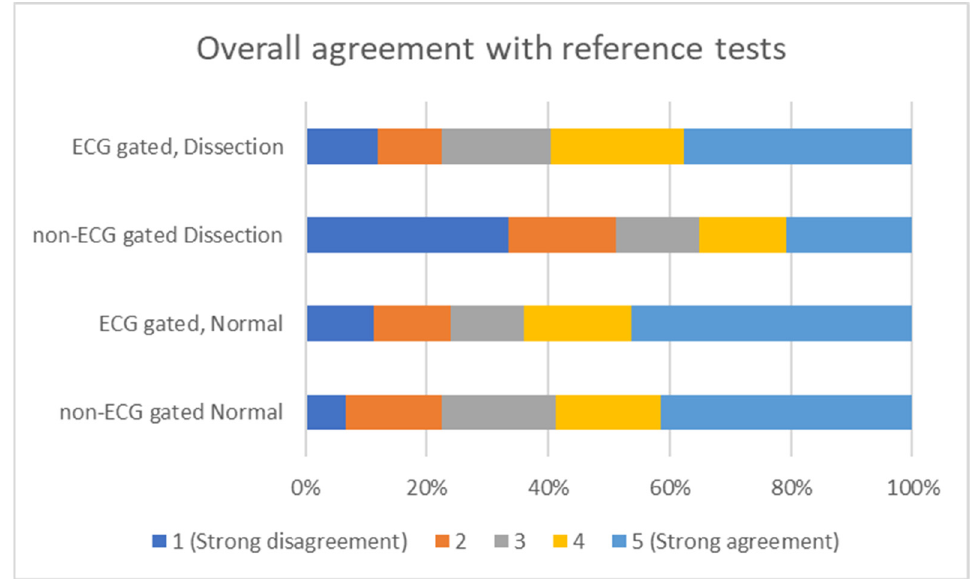
Figure 2. Overall agreement with reference tests, depending on the usage of ECG gating for CTA image